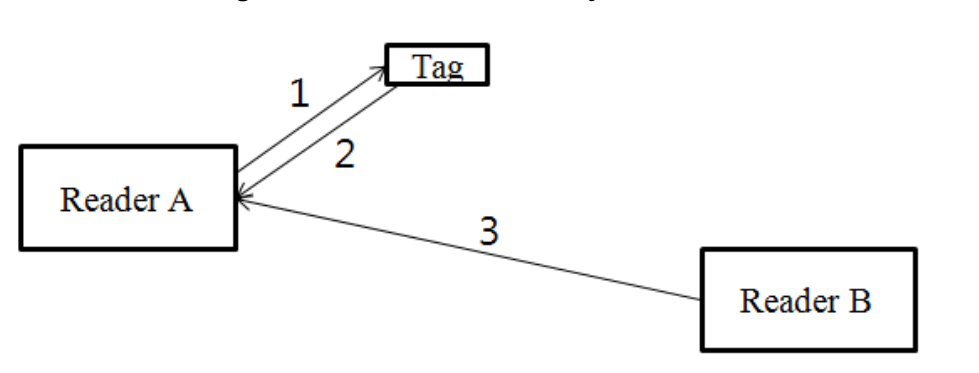
Figure 3. Interference caused by Reader